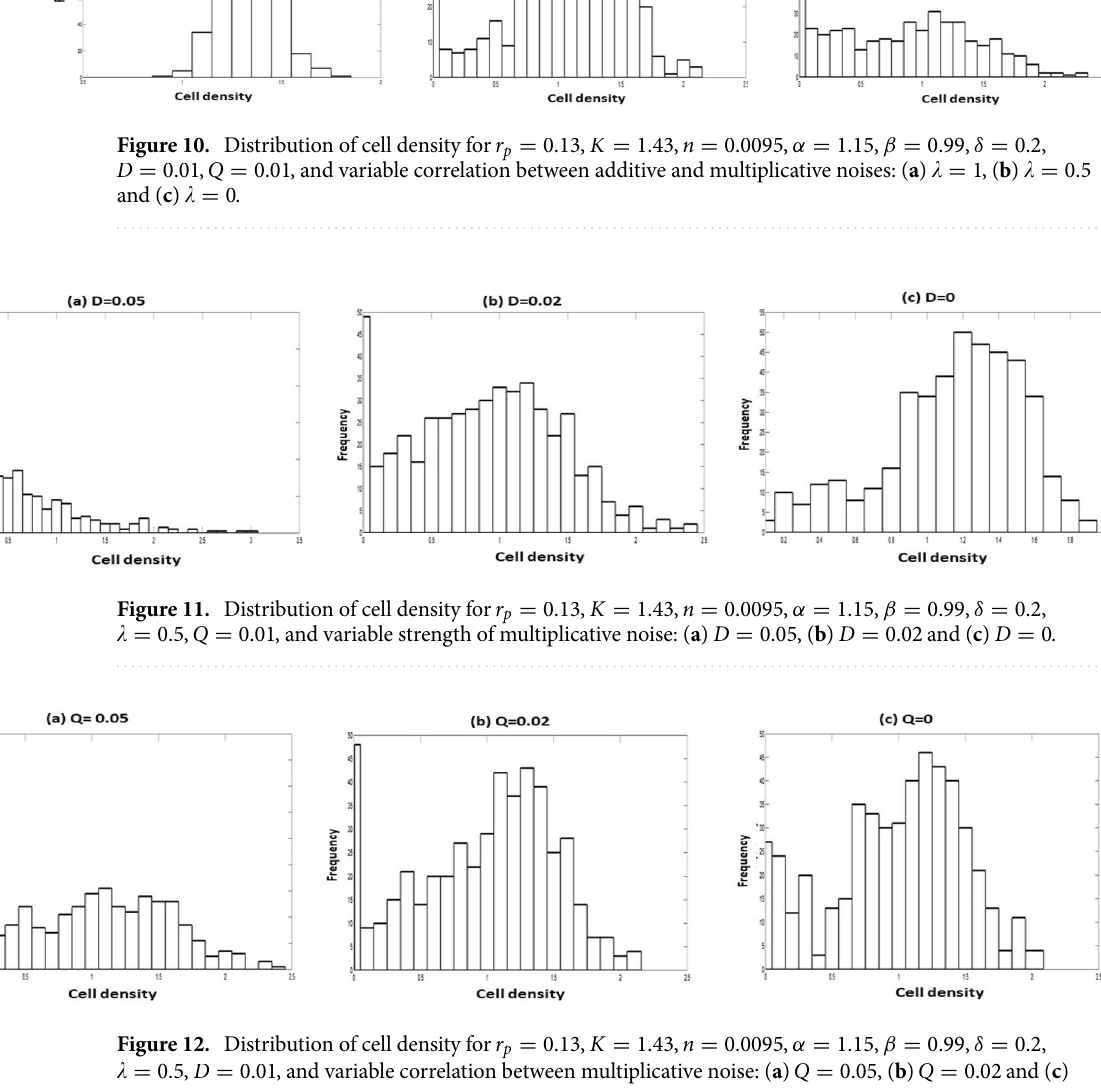
1.15 , β 0.2 , 0.99 , δ = = = 0.05 , ( b ) Q 0.02 and ( c ) = =